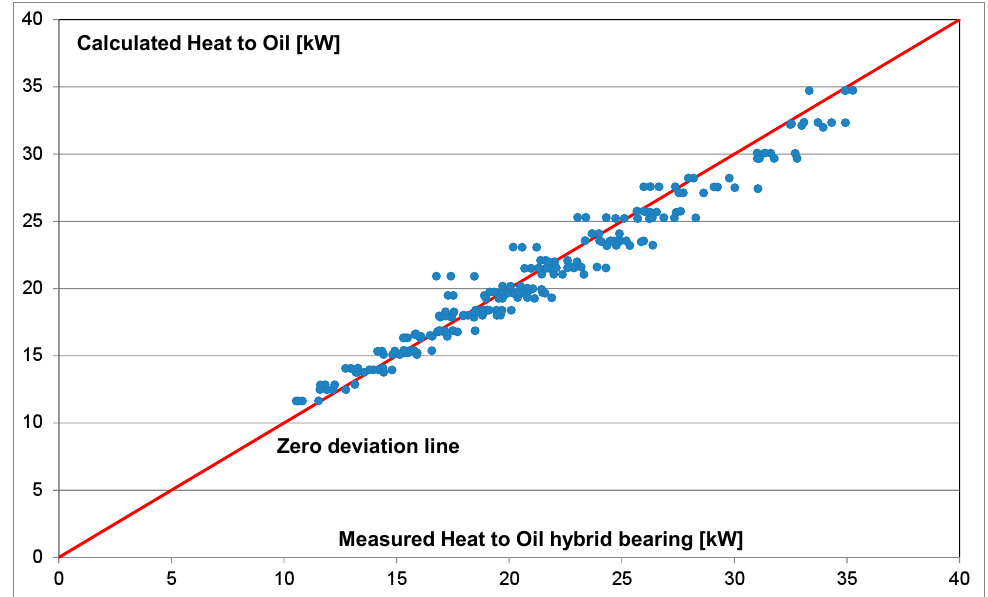
Figure 7. Heat to oil produced by the hybrid bearing vs. correlation. The average deviation is less than 2%.